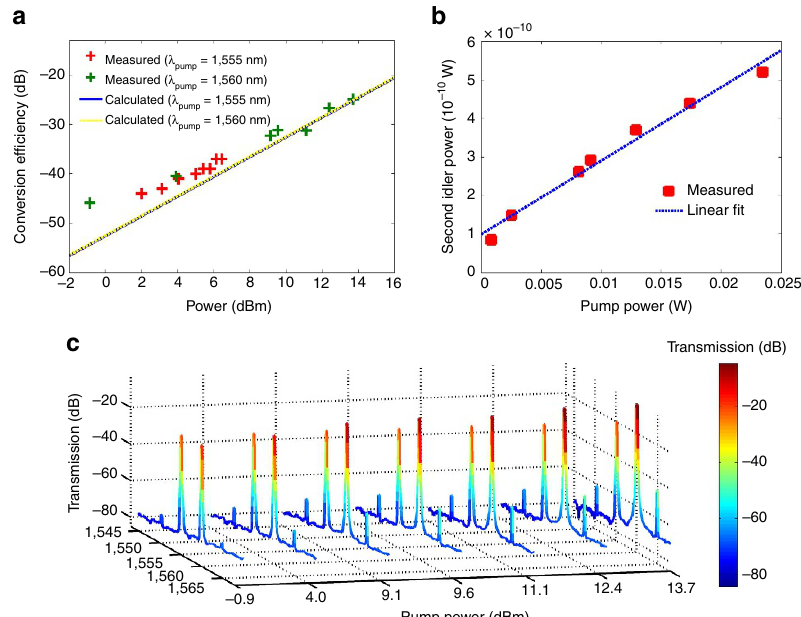
Figure 4 | Characterization of the USRN waveguide conversion efficiency. ( a ) Measured conversion efficiency as a function of pump power. Blue solid and yellow dashed lines represent the calculated conversion efficiency as a function of pump power for a pump wavelength of 1,555 and 1,560nm, respectively. ( b ) Four-wave-mixing experiments using a pump at 1,560nm and a signal at 1,555nm. ( c ) Evolution of the spectrum measured at the USRN waveguide output as the pump power (at 1,560nm) is increased. The first and second idler powers are observed to increase with pump power. NATURE COMMUNICATIONS|8:13878|DOI: